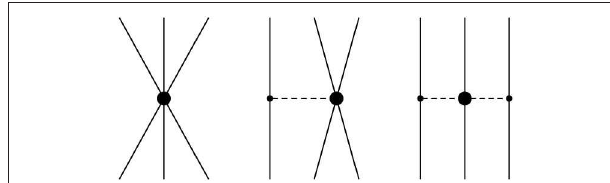
FIGURE 8 | Leading three-baryon interactions: contact term, one-meson exchange, and two-meson exchange. Filled circles and solid dots denote vertices with 1 i 1 and 1 i 0, = =